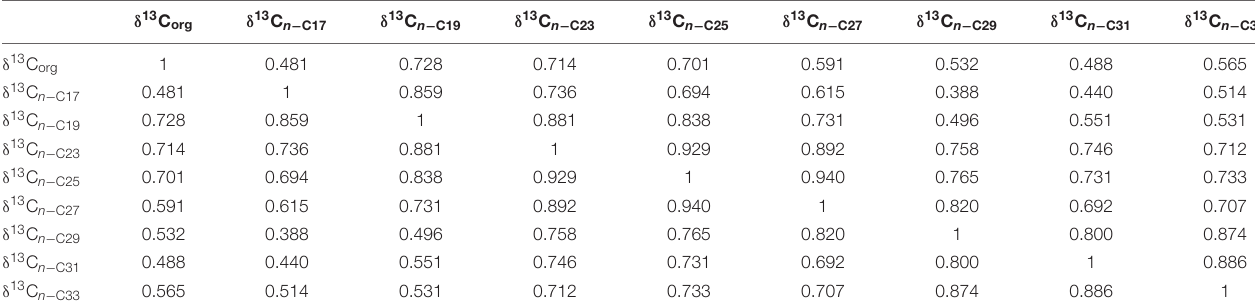
or methylotrophic bacteria. The methylotrophic bacteria prefer to consume isotopically lighter methane generated from the methanogens and would consequently result in isotopically lighter lipids (biomarkers) (Games et al., 1978), while the δ 13 C composition of C 30 -4-methyl steranes are in the range of − 11.93 to − 6.28 ( Table 3 ) which are very heavier. Therefore, the high abundance of C 30 -4-methyl steranes was most likely derived from Dinoflagellates due to its much heavier δ 13 C composition.